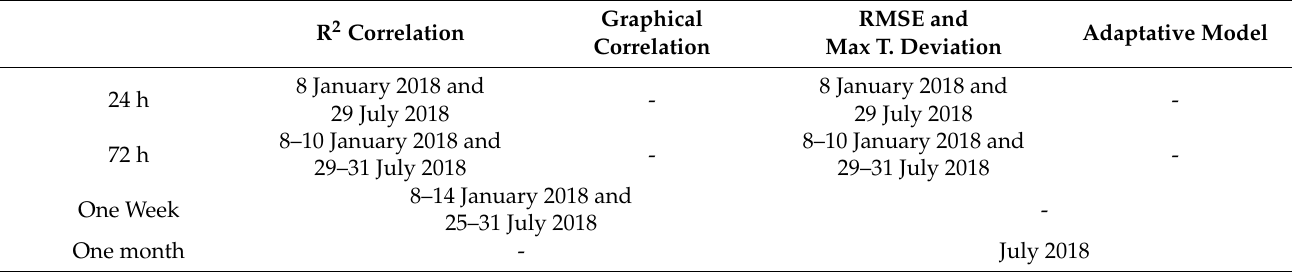
Table 4. Periods of time used to analyse the correlation between S1 to S4 alternatives and measured values. R 2 Correlation